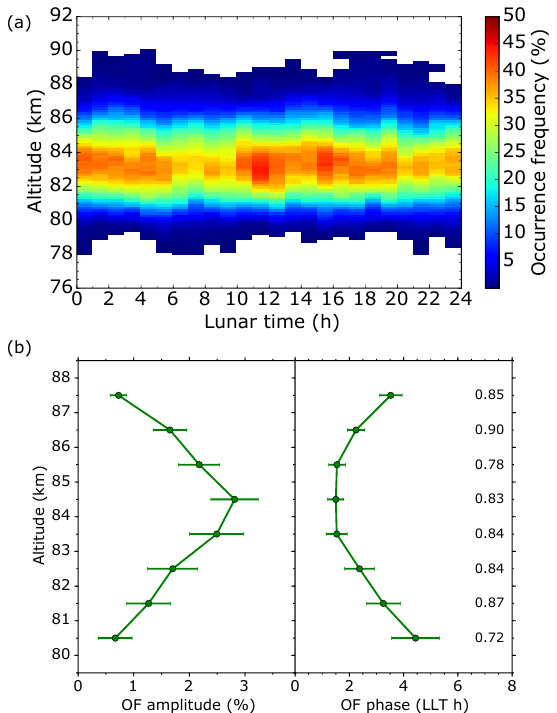
Figure 5. (a) Mean variations of NLC occurrence frequency with altitude and lunar time from 1997 to 2017. The plot contains 3450h of lidar measurements between 19 June and 29 July. (b) Semidiurnal amplitudes and phases determined from data of (a) . Black numbers are correlation coefficients of the harmonic fits for the correspond- ing